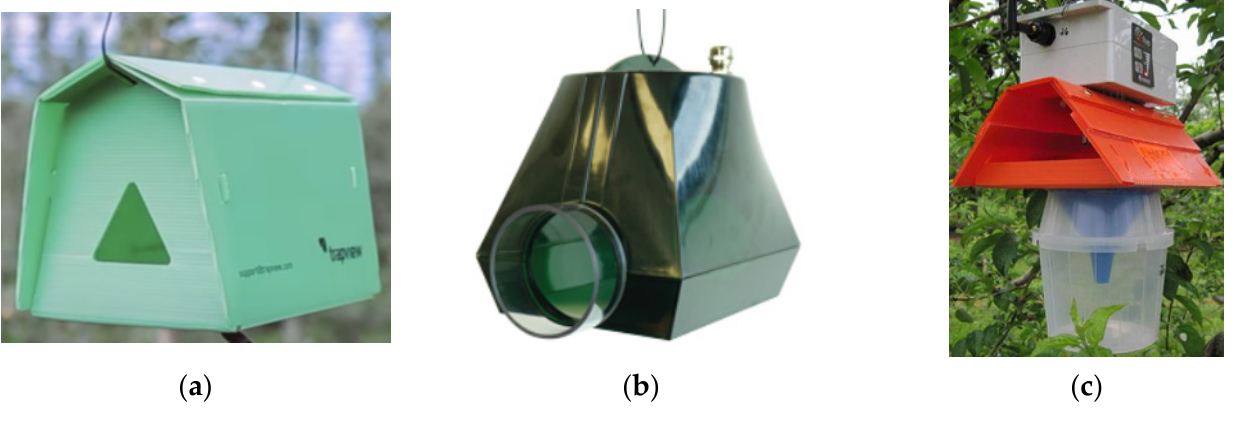
Figure 2. Commercial traps: ( a ) TrapView; ( b ) iSCOUT; ( c ) Z-Trap. The development of insect counting algorithms runs on two lines. In the first one, the original or a modified version of the well-known deep object detectors such as YOLO and Faster R-CNN are used for insect counting. In the second one, segmentation and classification are separated from each other. In the articles dealing with C. pomonella , the second one is the popular approach.